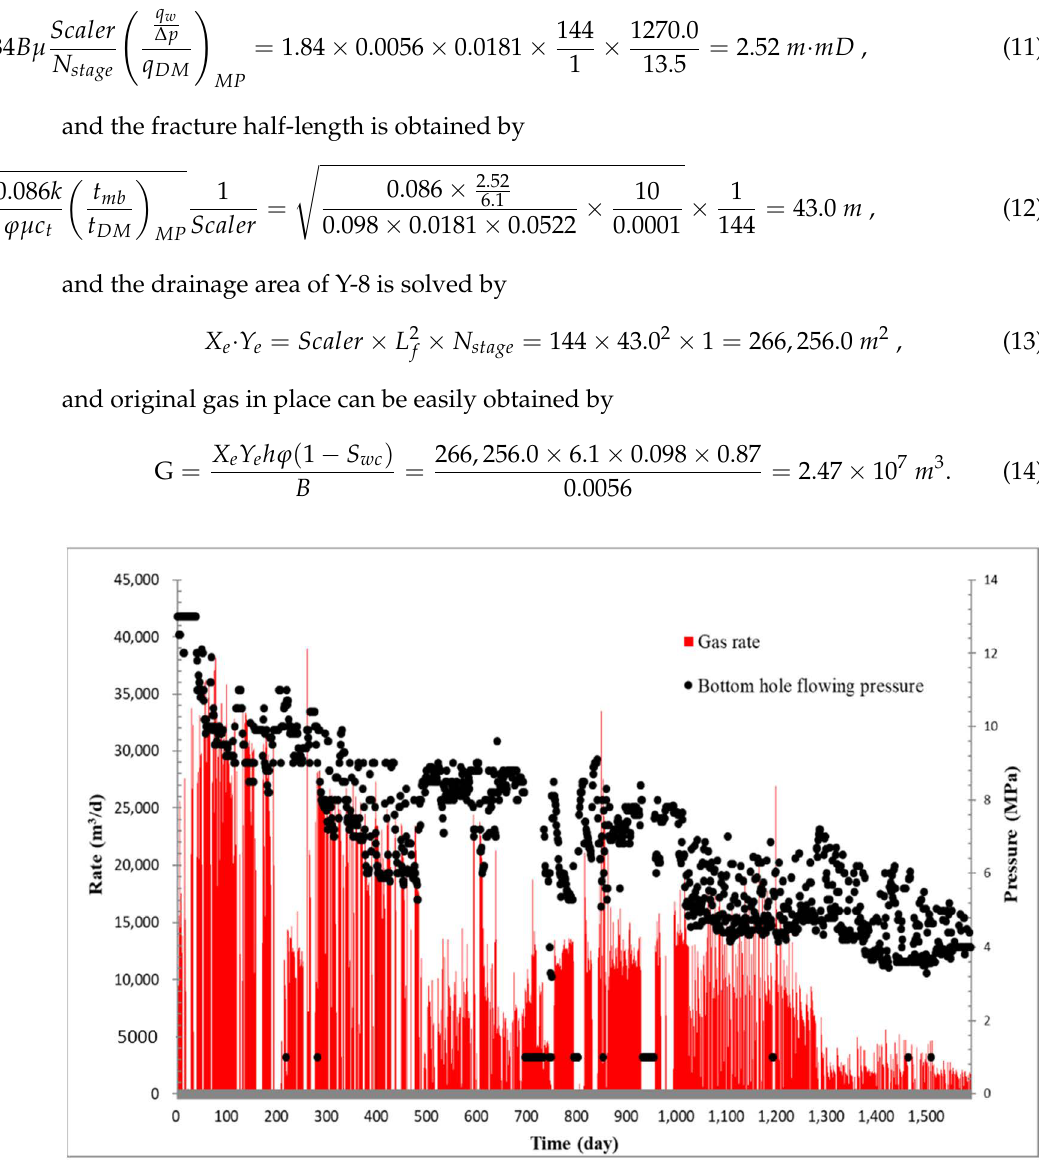
Figure 6. Daily production dynamics of the well Y-8. Table 3. Basic parameters of the reservoir and well